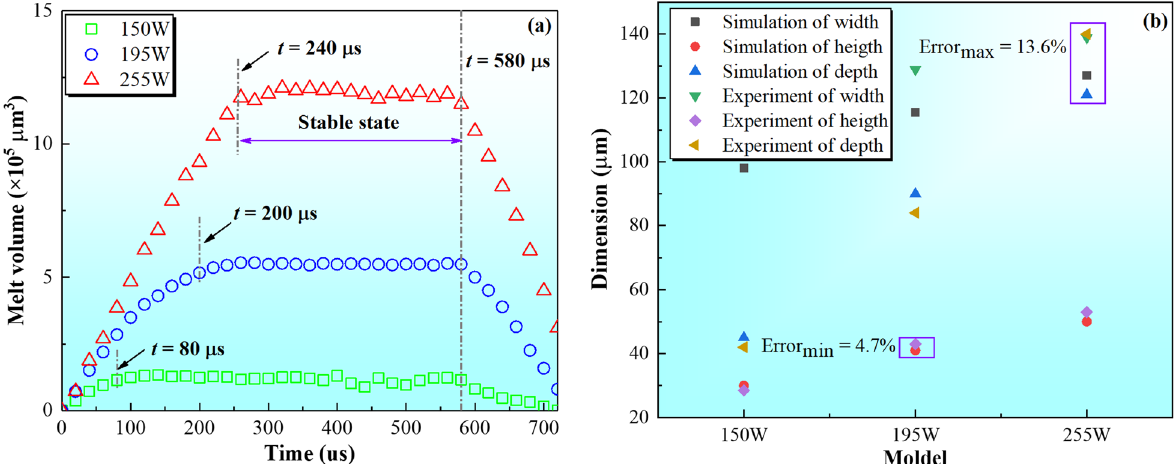
Figure 9 a Variation of melt volume with time and b The maximum molten pool dimensions in the stable state